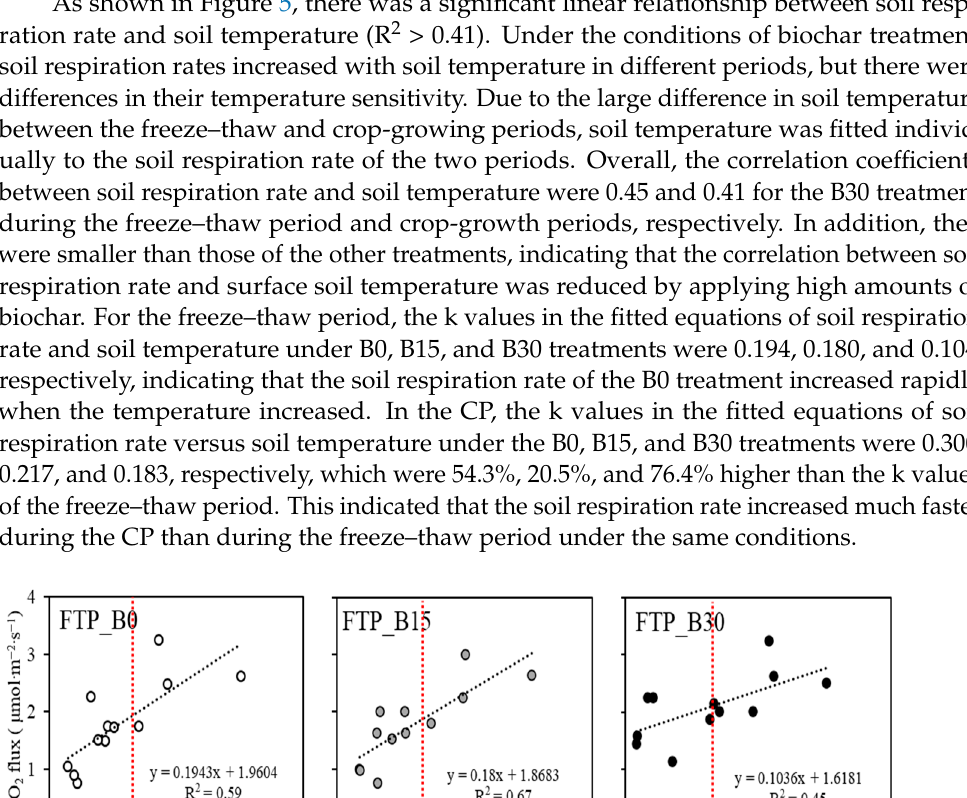
Figure 6. Relationship between soil respiration rate and soil moisture content for different biochar additions. 3.5. Correlation Analysis of Soil Respiration and Soil Organic Carbon with Environmental Factors Figure 7 presents the correlation between soil respiration rate, soil organic carbon, and environmental factors under biochar addition. The activities of available K, NO - 3 -N, soil temperature, and soil moisture content in soils showed significantly positive correla- tions with soil respiration rate (CO 2 flux), with the coefficients of 0.526 ( p < 0.01), 0.410 ( p